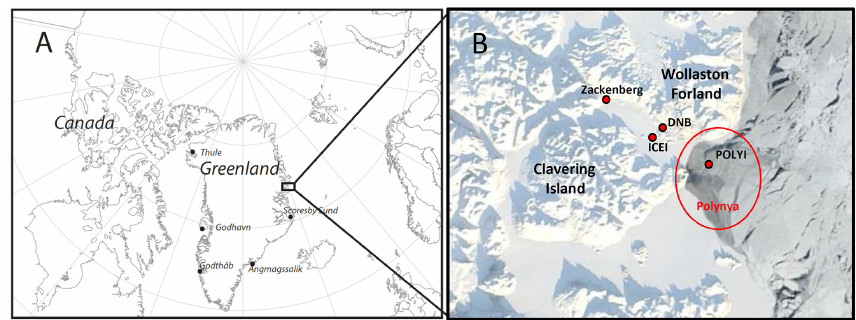
Figure 1. (a) Regional and (b) local overview of field sites in Young Sound, northeast Greenland. Sites ICEI and DNB were located in the inner fjord, characterized by thick, fast sea ice and a thick snow cover, and POLYI was located in an active polynya, characterized by thin ice and snow